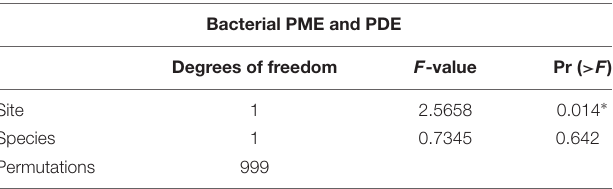
TABLE 4 | PERMANOVA for analysis of similarity/dissimilary among bacterial community from D. excelsa and P. montana . Bacterial PME and